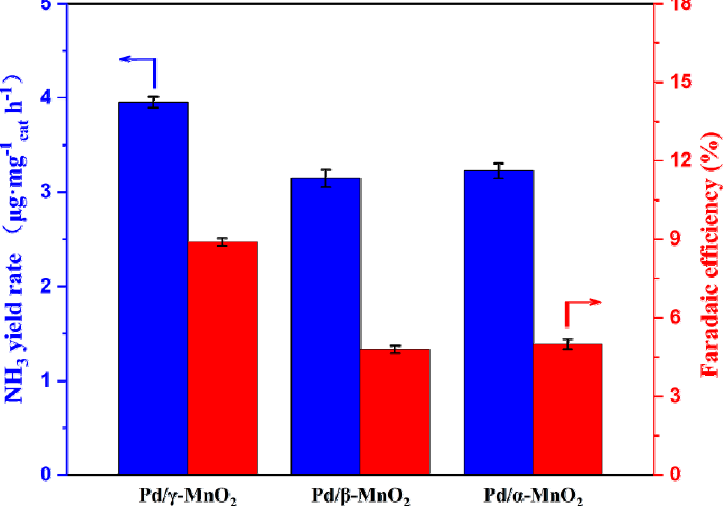
Figure 7. Electrochemical impedance spectra of Pd / γ -MnO 2 , Pd / C, and γ -MnO 2 catalysts.